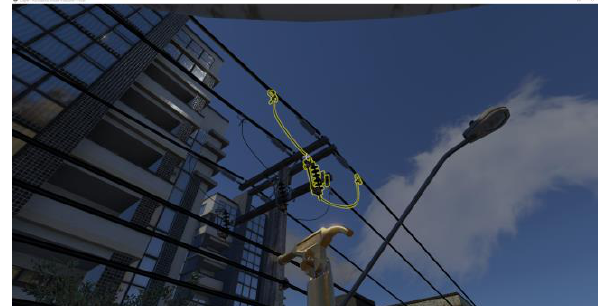
Figure 12. Electrician opening fuse switches in the elevator bucket.